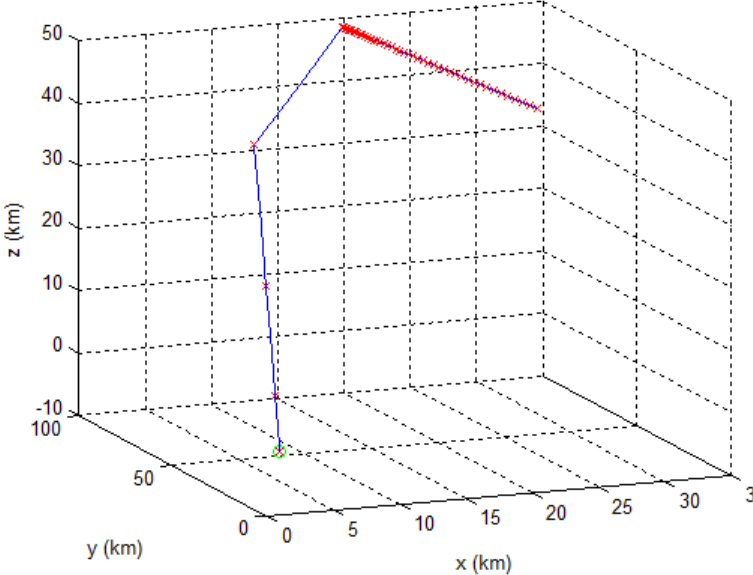
Figure 7. Baseline trajectory in the orbital frame ( ε = 2 , N = 4, TOF = 40 h) with non-zero initial inertial relative velocity ( V r = [ 50.0, − 60.0,80.0 ] T m/s).